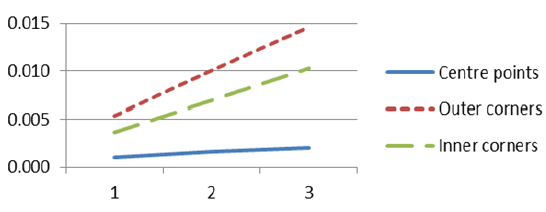
Figure 5. Standard deviations of plane to plane distances in m measured at plane centres and corners as a function of the number of loops in the corridor.